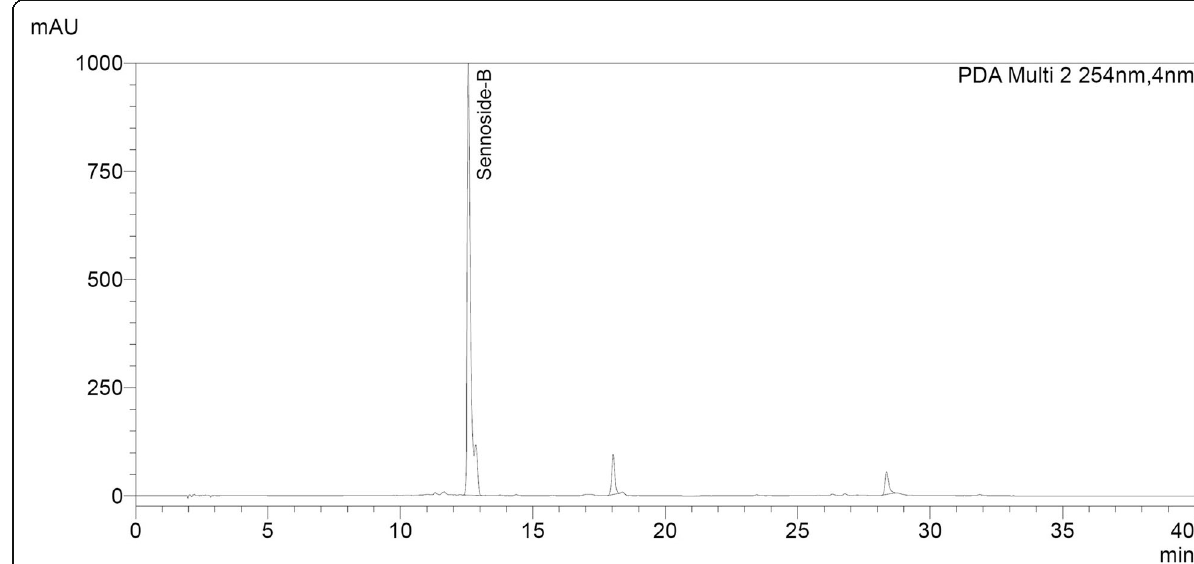
Fig. 7 HPLC chromatogram of